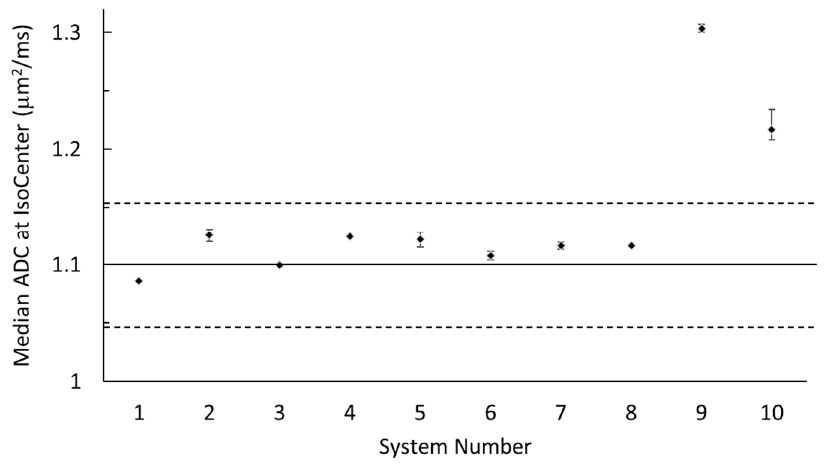
Figure 2. Median ADC measured at the isocenter of each system. Each data point is the median of all scans (up to 4) from each system, and error bars indicate the maximum and minimum (range of) isocenter ADC values. The solid line marks Dtrue (1.1 µm 2 /ms), and dashed lines are ±5% relative to Dtrue.